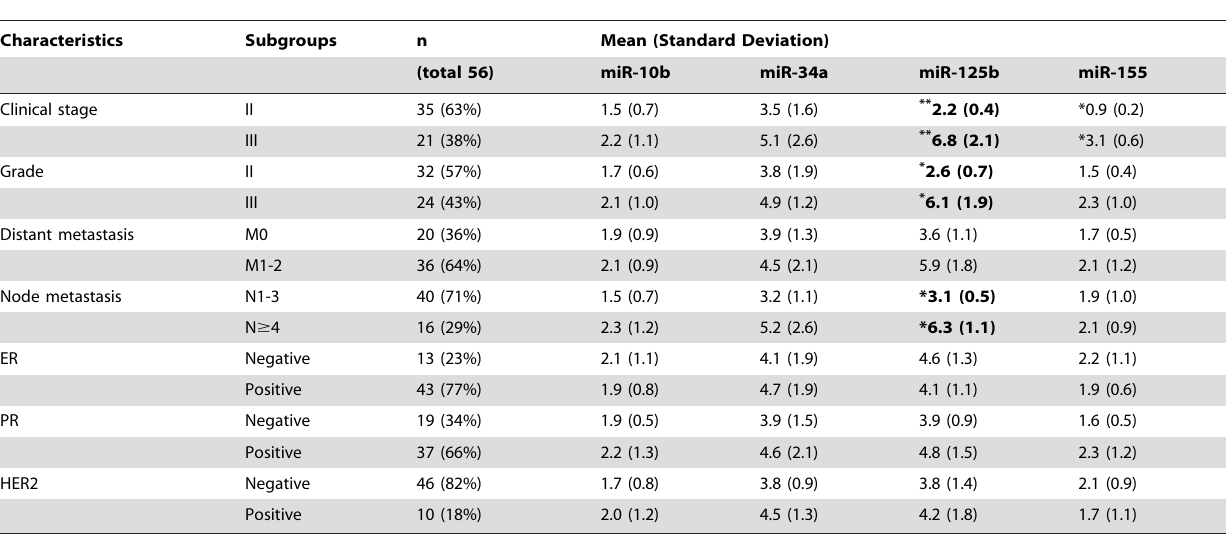
Table 1. Patients’ characteristics at the time of primary diagnosis of breast cancer and correlation with serum miRNA levels.